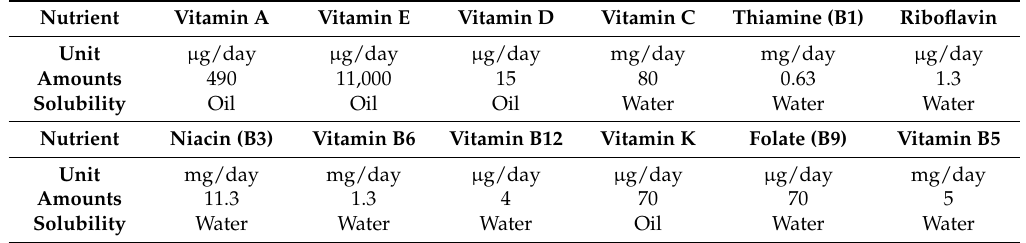
Table A2. AR from EFSA for a 30–39-year-old female with a PAL of 1.6